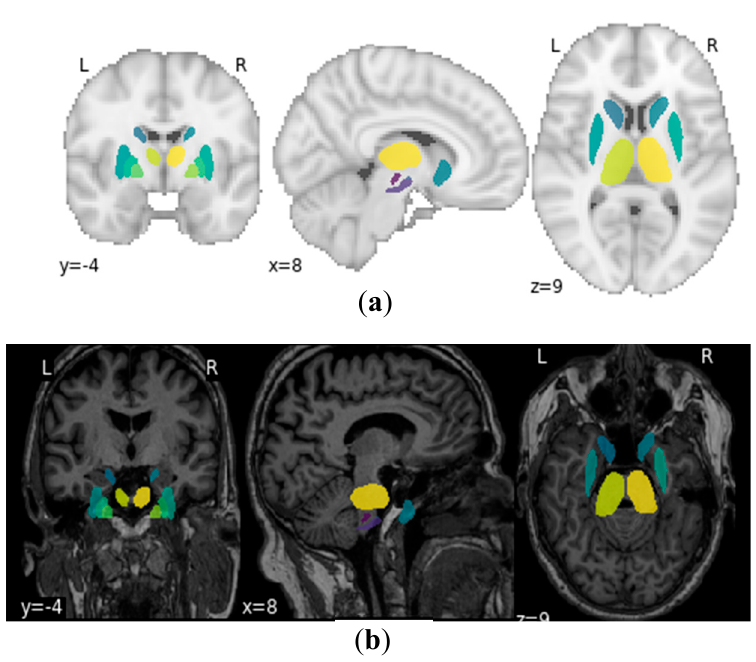
Figure 5. ROI plotting on ( a ) MNI-ICBM-152 template and ( b ) an acquired MRI scan from PPMI.